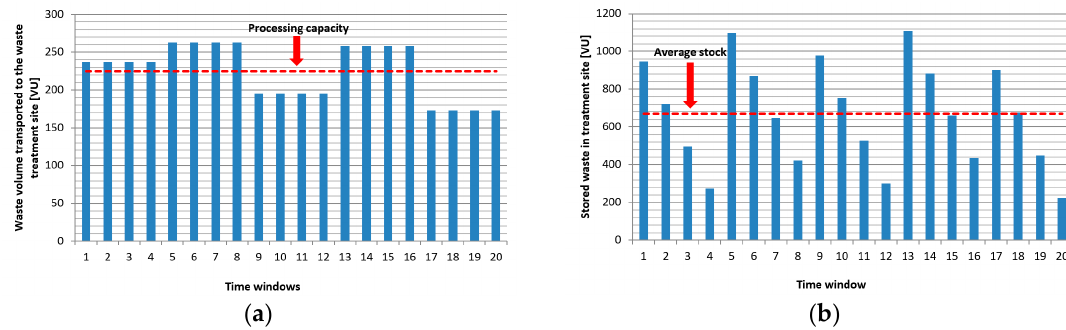
Figure 11. ( a ) Average waste volume between two supply transported to the waste treatment site in Scenario 1. The waste supply is not synchronized with the processing capacity, because the supplied volume of waste exceeded the required amount in the time windows 1 to 8 and 13 to 16, while not reached the required amount in time windows 9 to 12 and 17 to 20; and, ( b ) Waste inventory at the treatment site (average = 668 VU, max = 1109 VU).